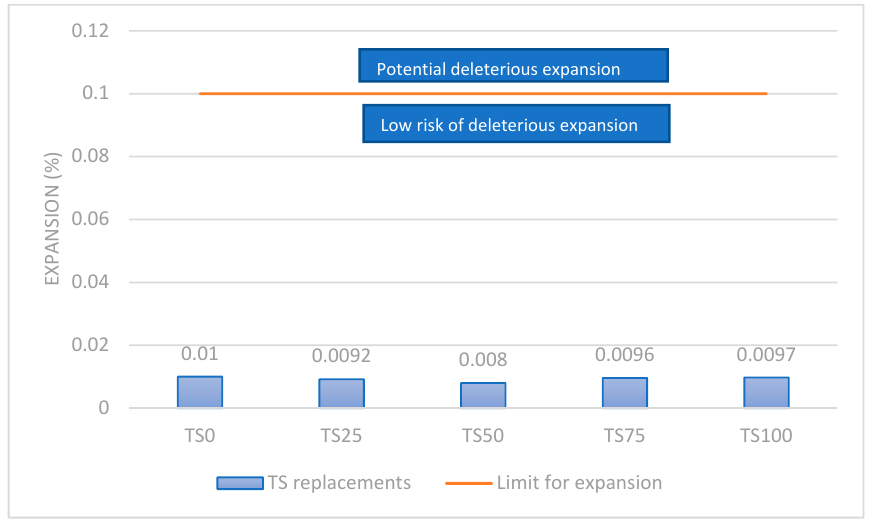
Figure 9. The expansion of the mortars at 14 days.